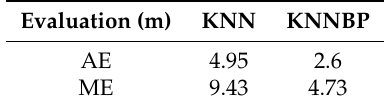
Table 2. Comparison of error evaluation. AE: average error; ME: maximum